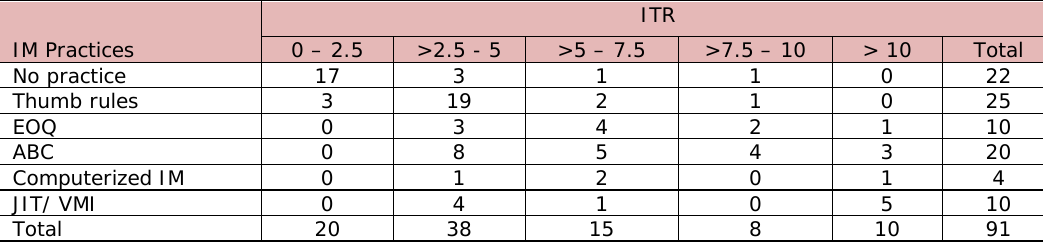
Table 9. “Inventory Practices and ITR”.